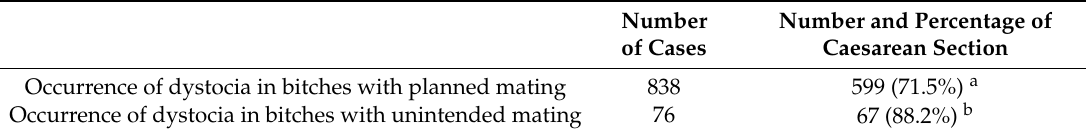
Table 5. The total number of dystocia cases recorded from 1981 to 2019 and the number and percentage of caesarean sections performed in bitches after planned ( n = 838) and unplanned mating ( n = 76). Number Number and Percentage of of Cases Caesarean Section Occurrence of dystocia in bitches with planned mating 838 599 (71.5%) a Occurrence of dystocia in bitches with unintended mating 76 67 (88.2%) b a,b —di ff erence statistically significant at p ≤